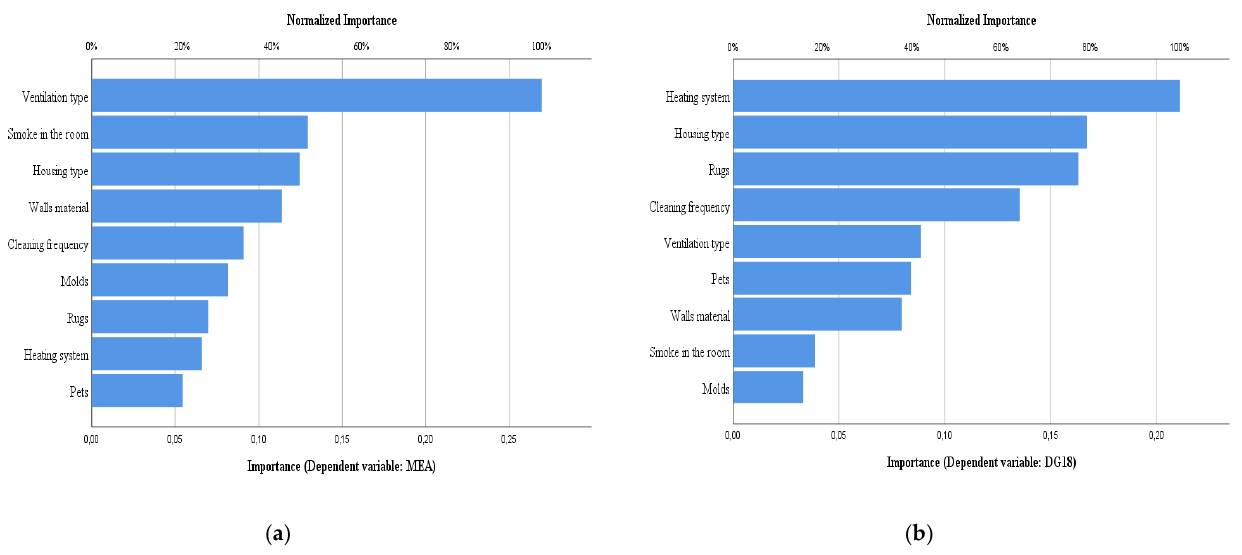
Figure 6. Normalized importance of housing characteristics for fungal counts. ( a ) MEA, ( b ) DG18.